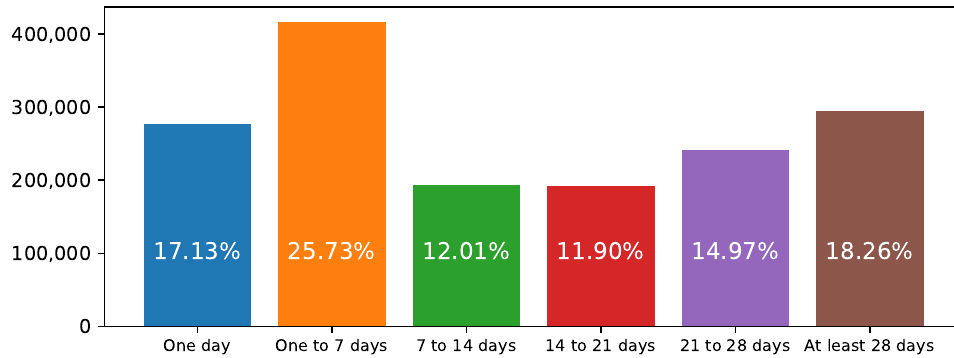
Figure 2. SIM card distribution in the 2017-04 data set by the number of active days.